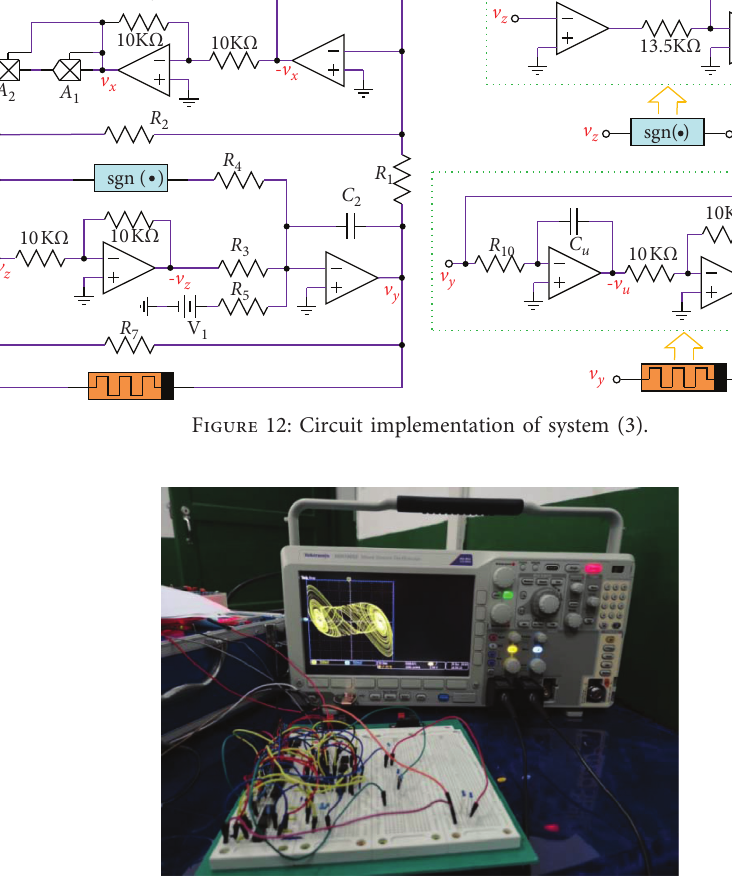
Figure 13: The hardware circuit test setup to realize system